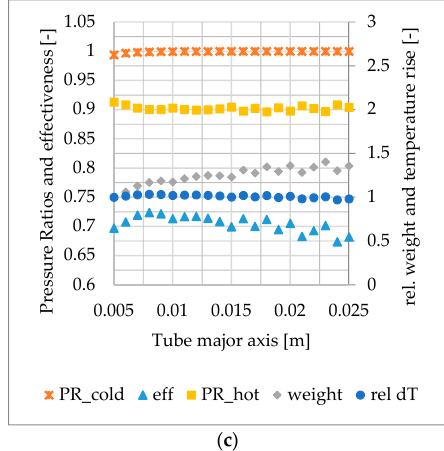
Figure 6. Parametric studies of the MHX of: ( a ) the hot-side inlet Mach number; ( b ) the number of columns per pass; and ( c ) the tube dimensions.